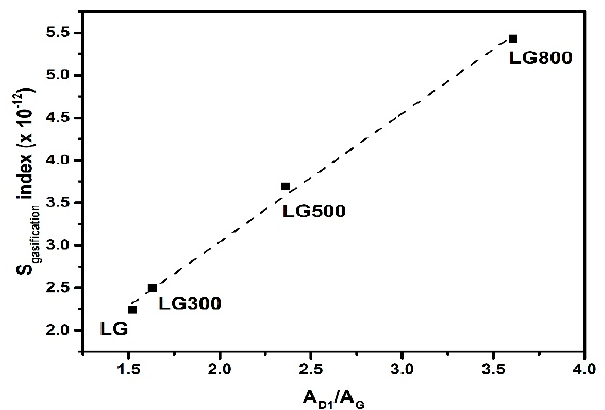
Figure 6. Relationship between the comprehensive characteristic gasification index (S) and A D1 /A G ratio.